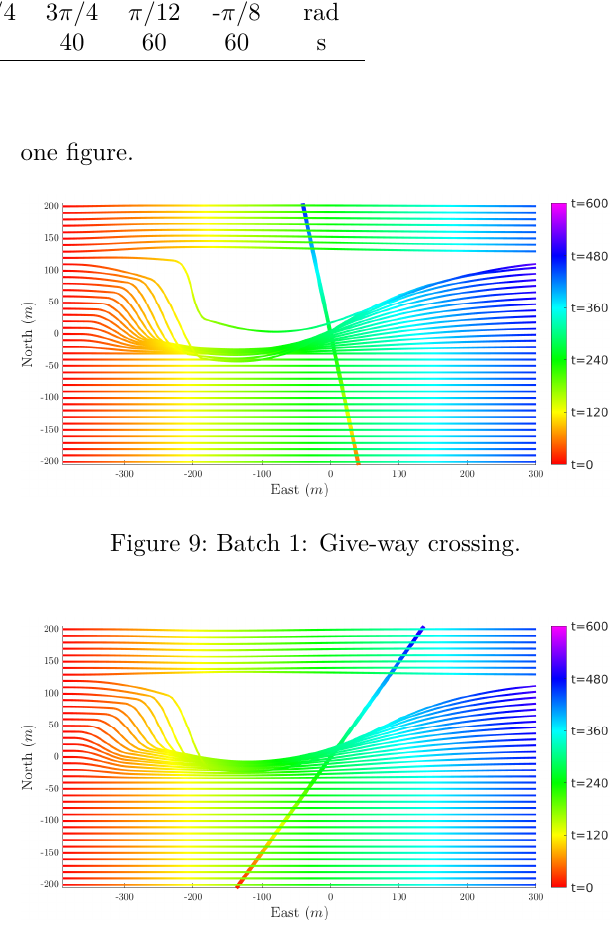
Figure 10: Batch 2: Give-way